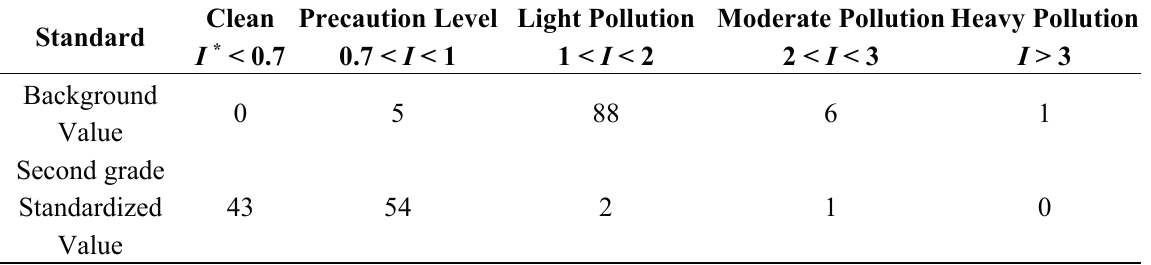
Table 4. The evaluated results of heavy metal pollution in soils